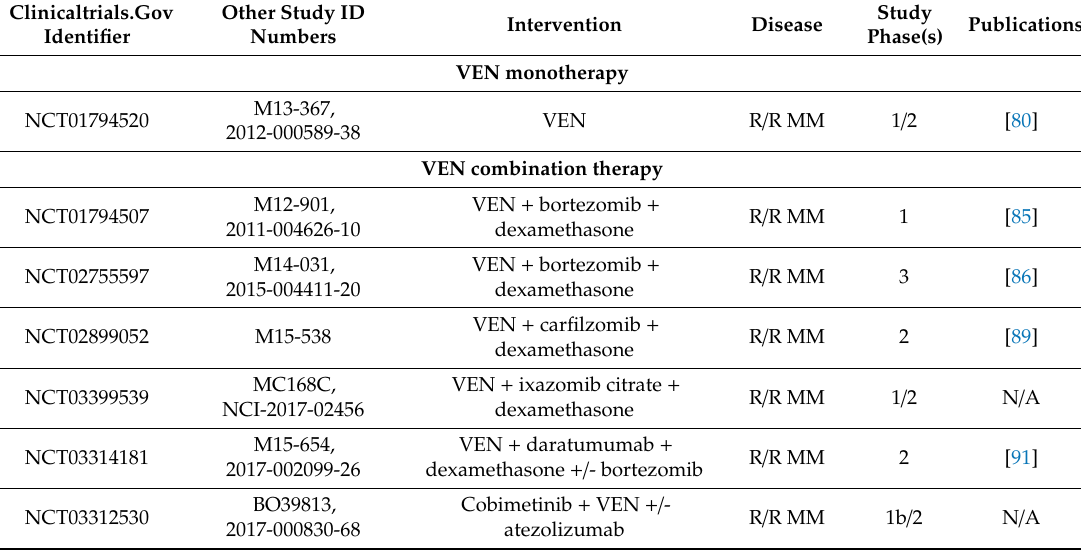
Table 3. Selected clinical trials of venetoclax in multiple myeloma